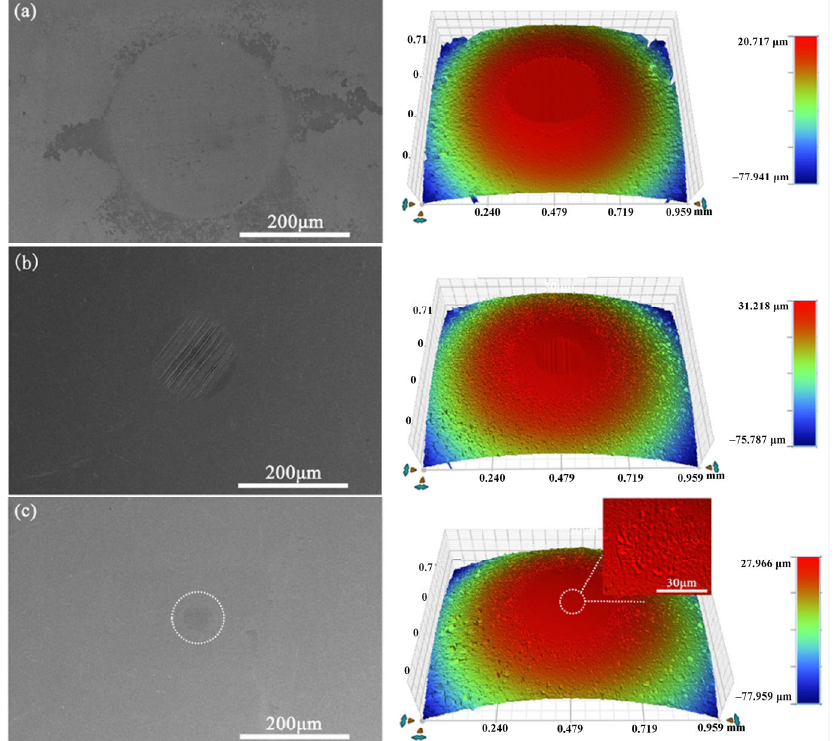
Fig. 9 SEM micrographs and 3D profile of the worn steel surface lubricated by (a) distilled water, (b) commercial products water-based lubricants, and (c) distilled water containing 0.6% water-soluble Cu nanoparticles ( the insert is the enlarge figure of wear